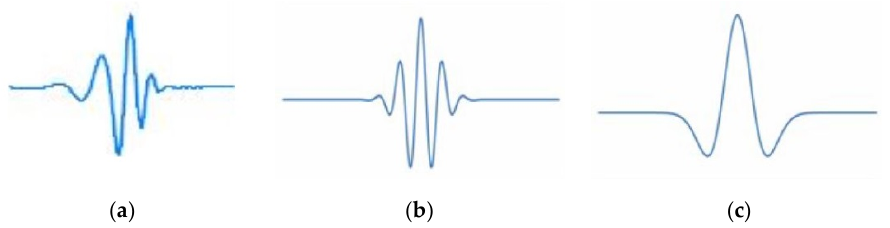
Figure 14. Wavelets used in the research: ( a ) Daubechies of 6th row, ( b ) Morlet, ( c ) Mexican hat [5].